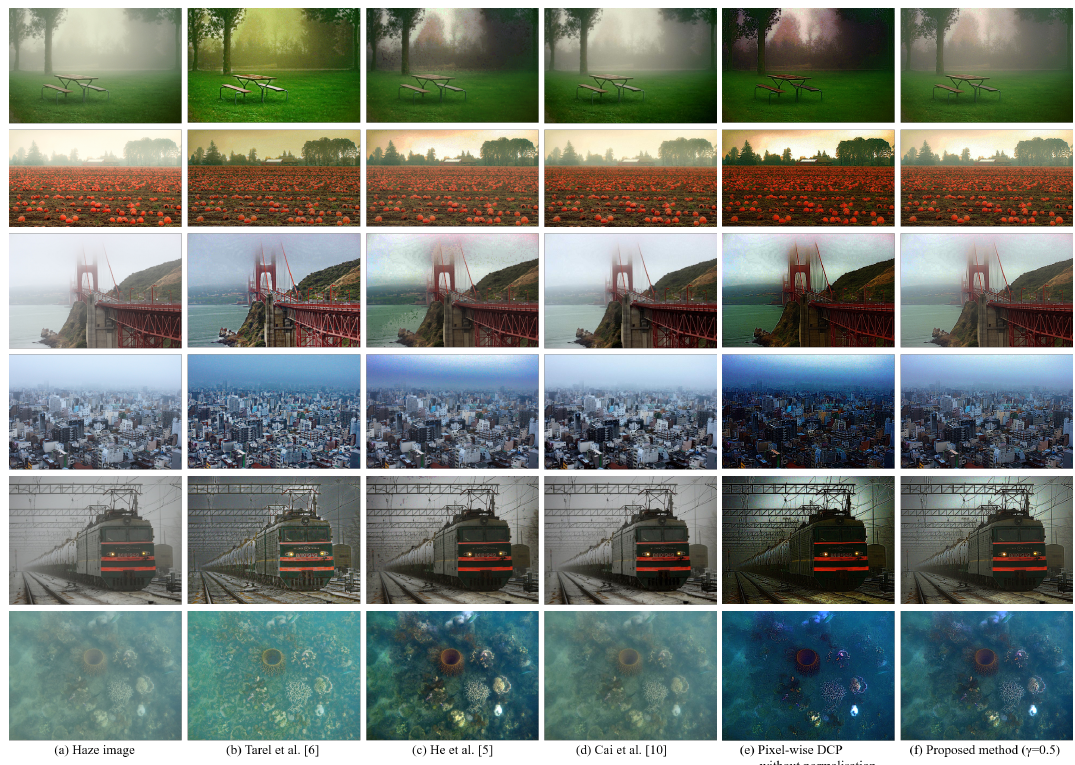
Figure 9. Comparison of haze-removal results by our proposed method with conventional methods applied to actual haze images. ( a ) Haze image, ( b ) Tarel et al. [6], ( c ) He et al. [5], ( d ) Cai et al. [10],